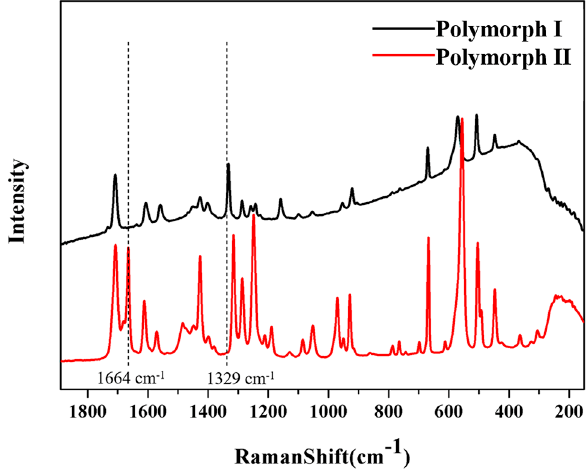
Figure 6. Raman spectra of polymorph I and polymorph II of theophylline.